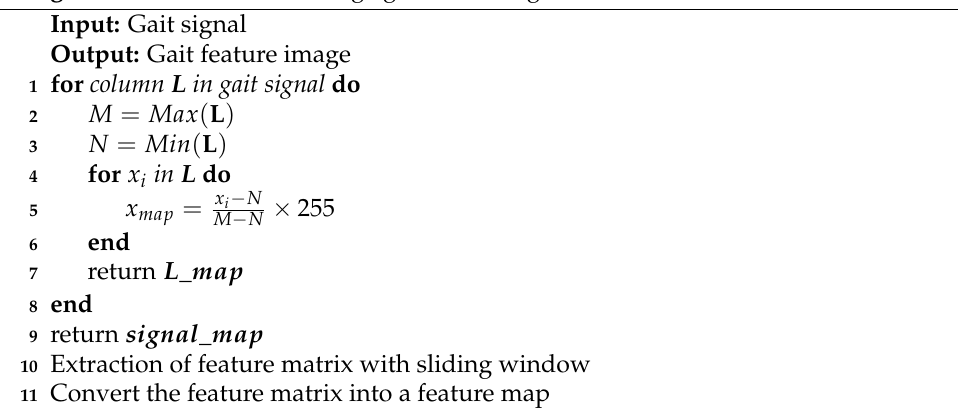
Algorithm 2: Gait feature image generation algorithm.